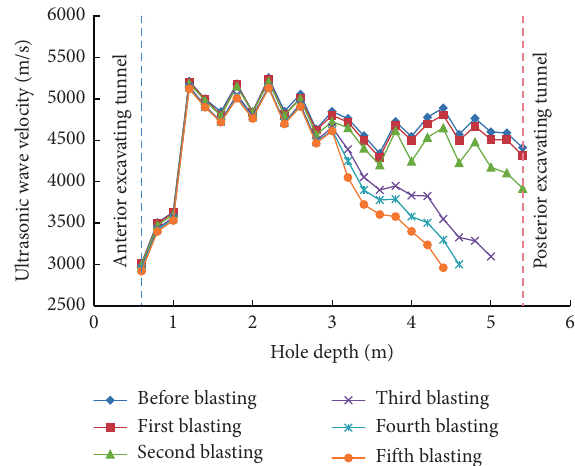
Figure 6: The relation curves between the ultrasonic wave velocity and the hole depth ( L 1).